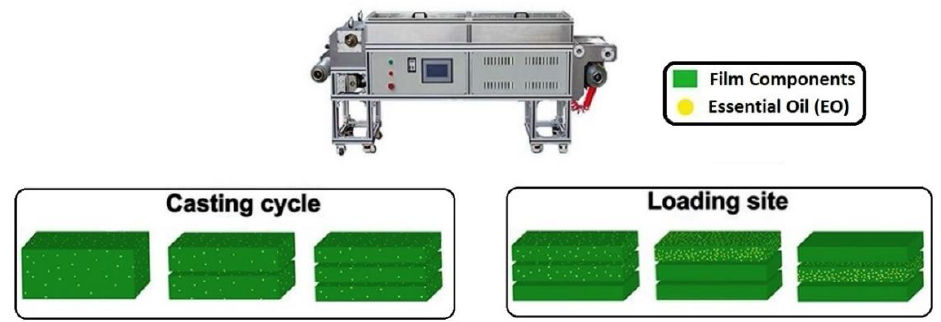
Figure 15. Schematic diagram showing casted films with different casting cycles and loading positions of Eos. Reproduced with minor modification from [59]. Copyright 2020 Elsevier.